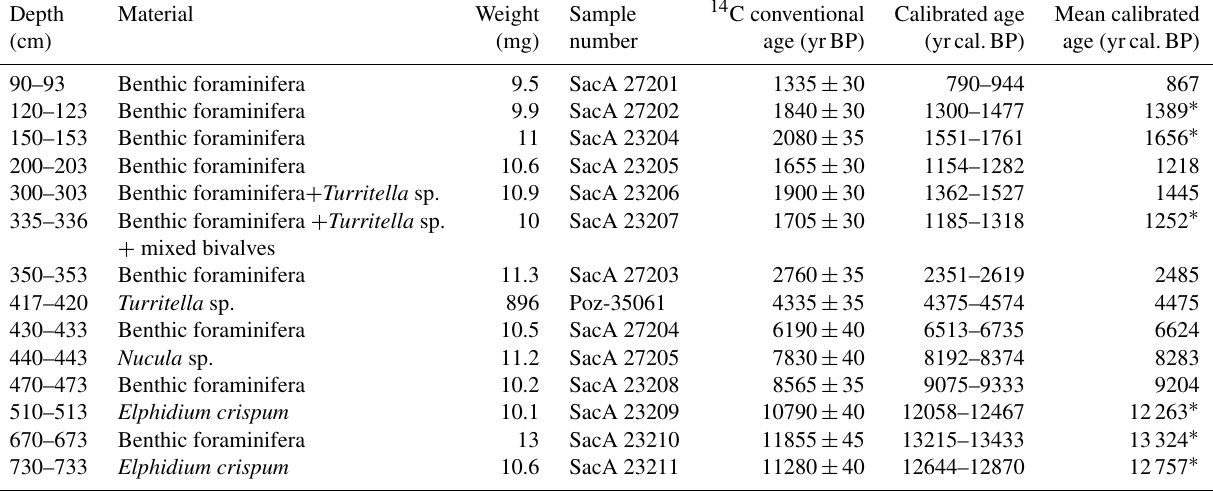
Table 2. Summary of 14 C dates. Absolute dates were obtained with accelerator mass spectrometer (AMS) 14 C dating of well-preserved shells and benthic foraminifera at Laboratoire de Mesure 14 C (LMC14) at Commissariat à l’Energie Atomique (CEA, Saclay) and at Poznan Radiocarbon Laboratory (PRL). The ages reported herein are delta 13 C-normalized conventional 14 C years, corrected for an assumed air-sea reservoir effect of 400 years. Calendar ages were calculated using Clam software (Blaauw, 2010) and the Marine13 calibration curve (Reimer et al.,